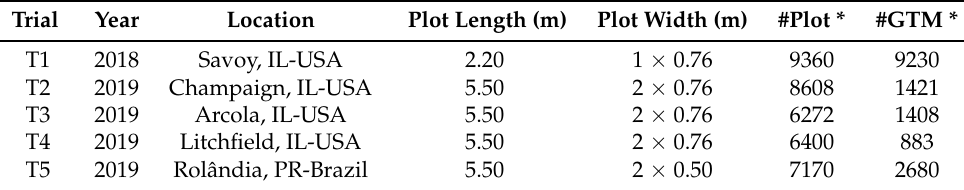
* #Plot: total number of plots in the trial; #GTM: number of plots with ground truth